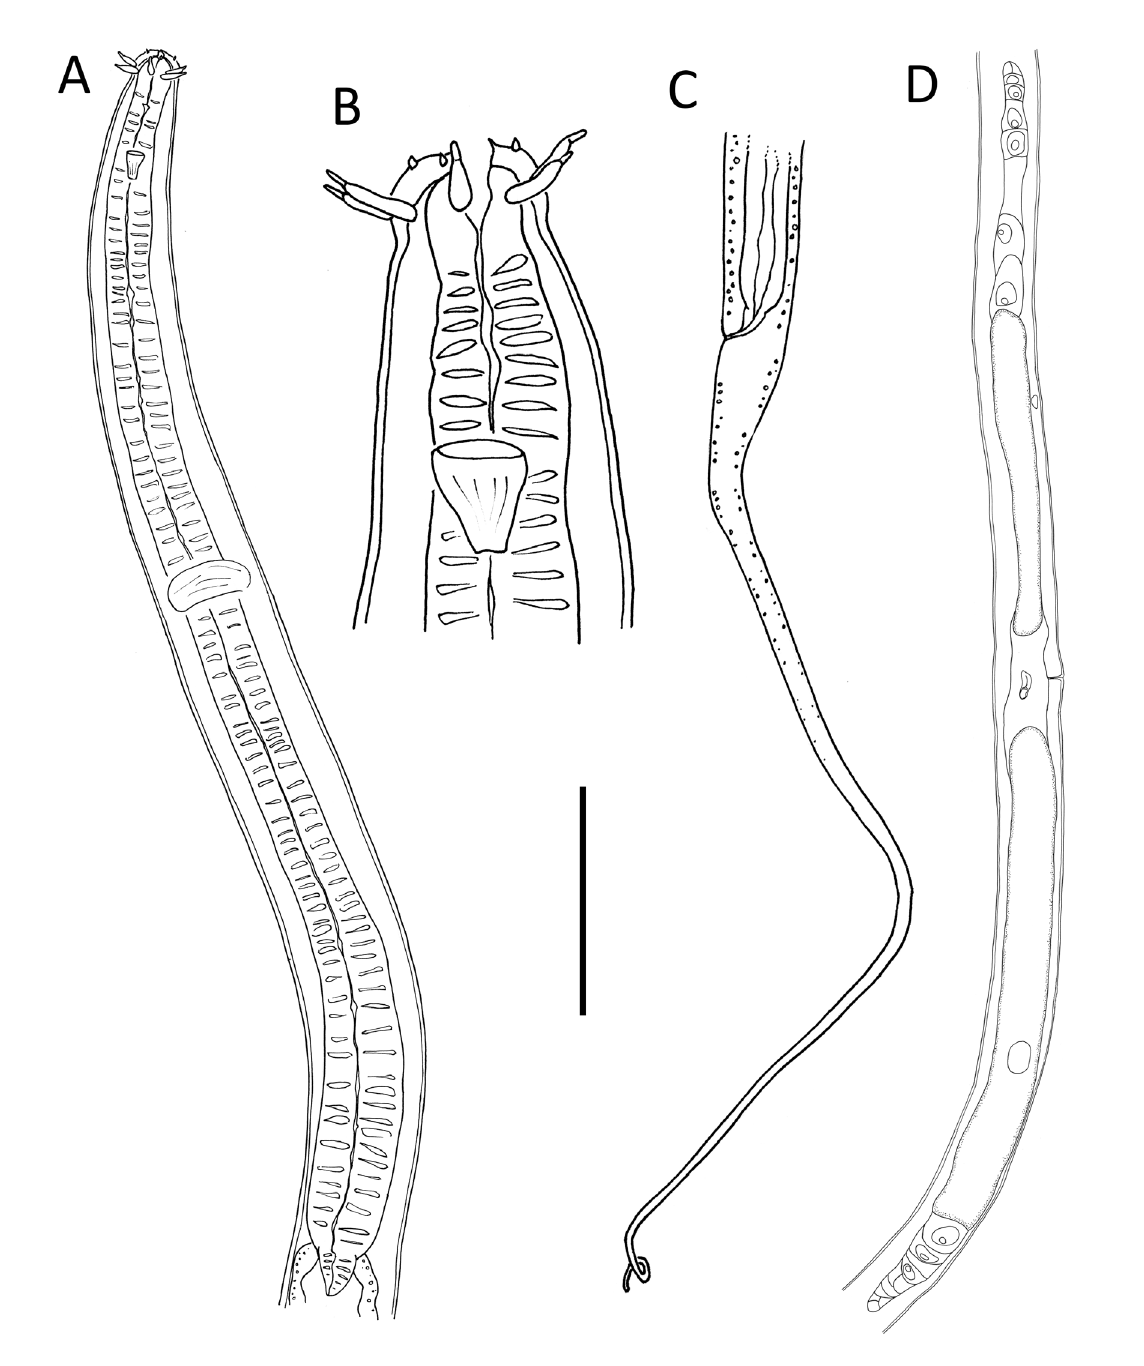
Fig. 3. Trefusialaimus idrisi Leduc, 2013, ♀ (NIWA139242). A . Anterior body region. B . Cephalic region. C . Posterior body region. D . Reproductive system. Scale bars: A = 50 μm; B = 20 μm; C = 90 μm; D = 125